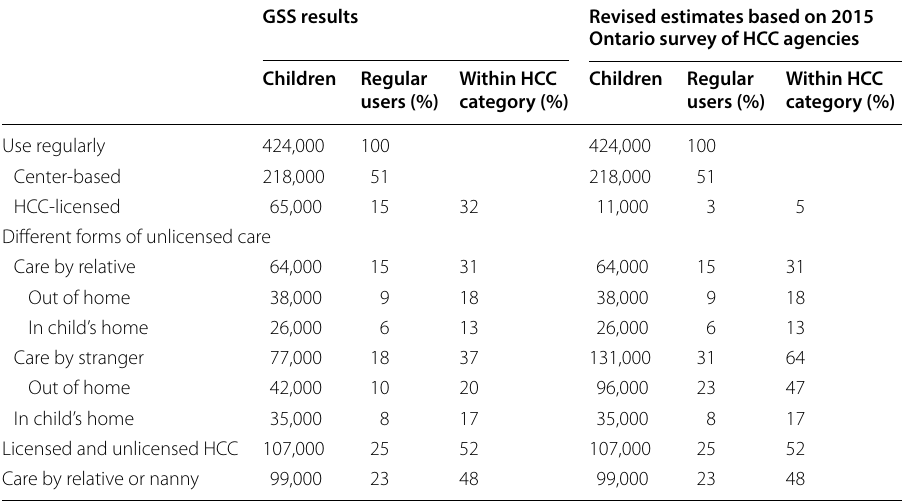
Table 3 Ontario child care usage from the GSS and revised estimates based on 2015 Ontario survey of HCC agencies GSS